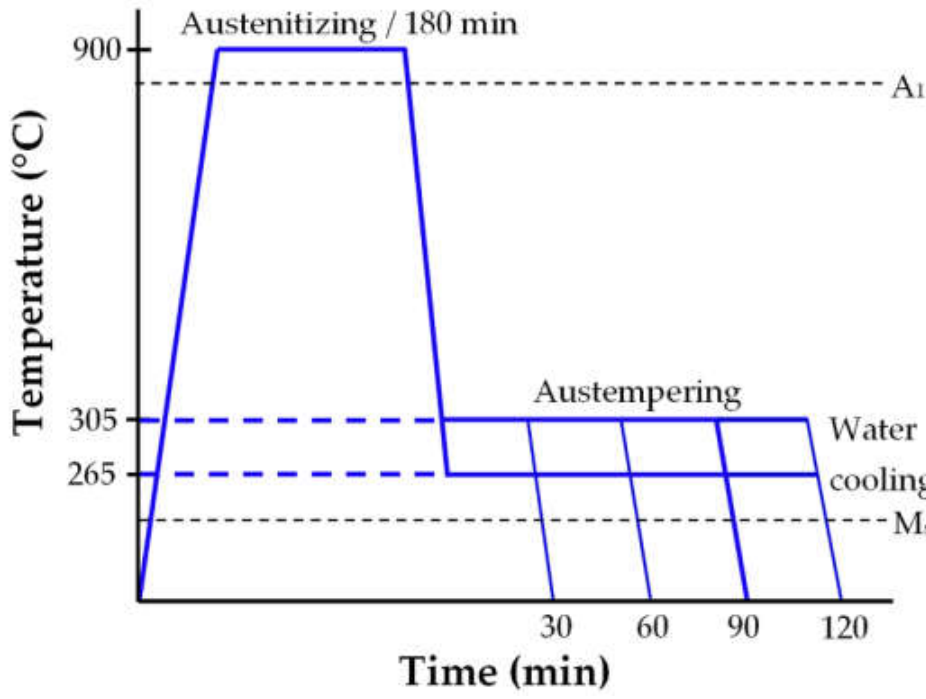
Figure 2. Austempering heat treatment cycles for temperatures of 265 and 305